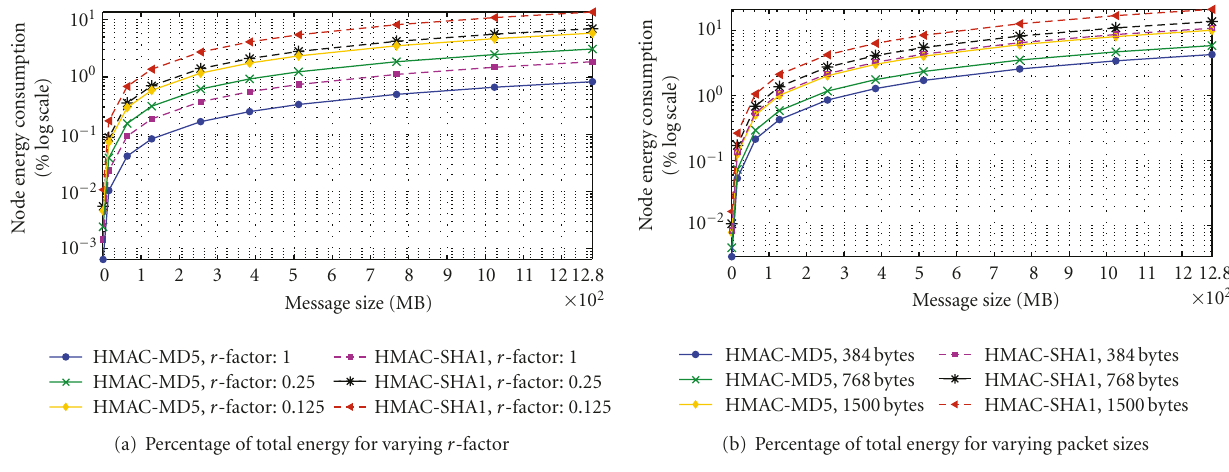
Figure 17: Energy consumption of extended TESLA protocol on ARM1176JZ(F) for di ff erent message